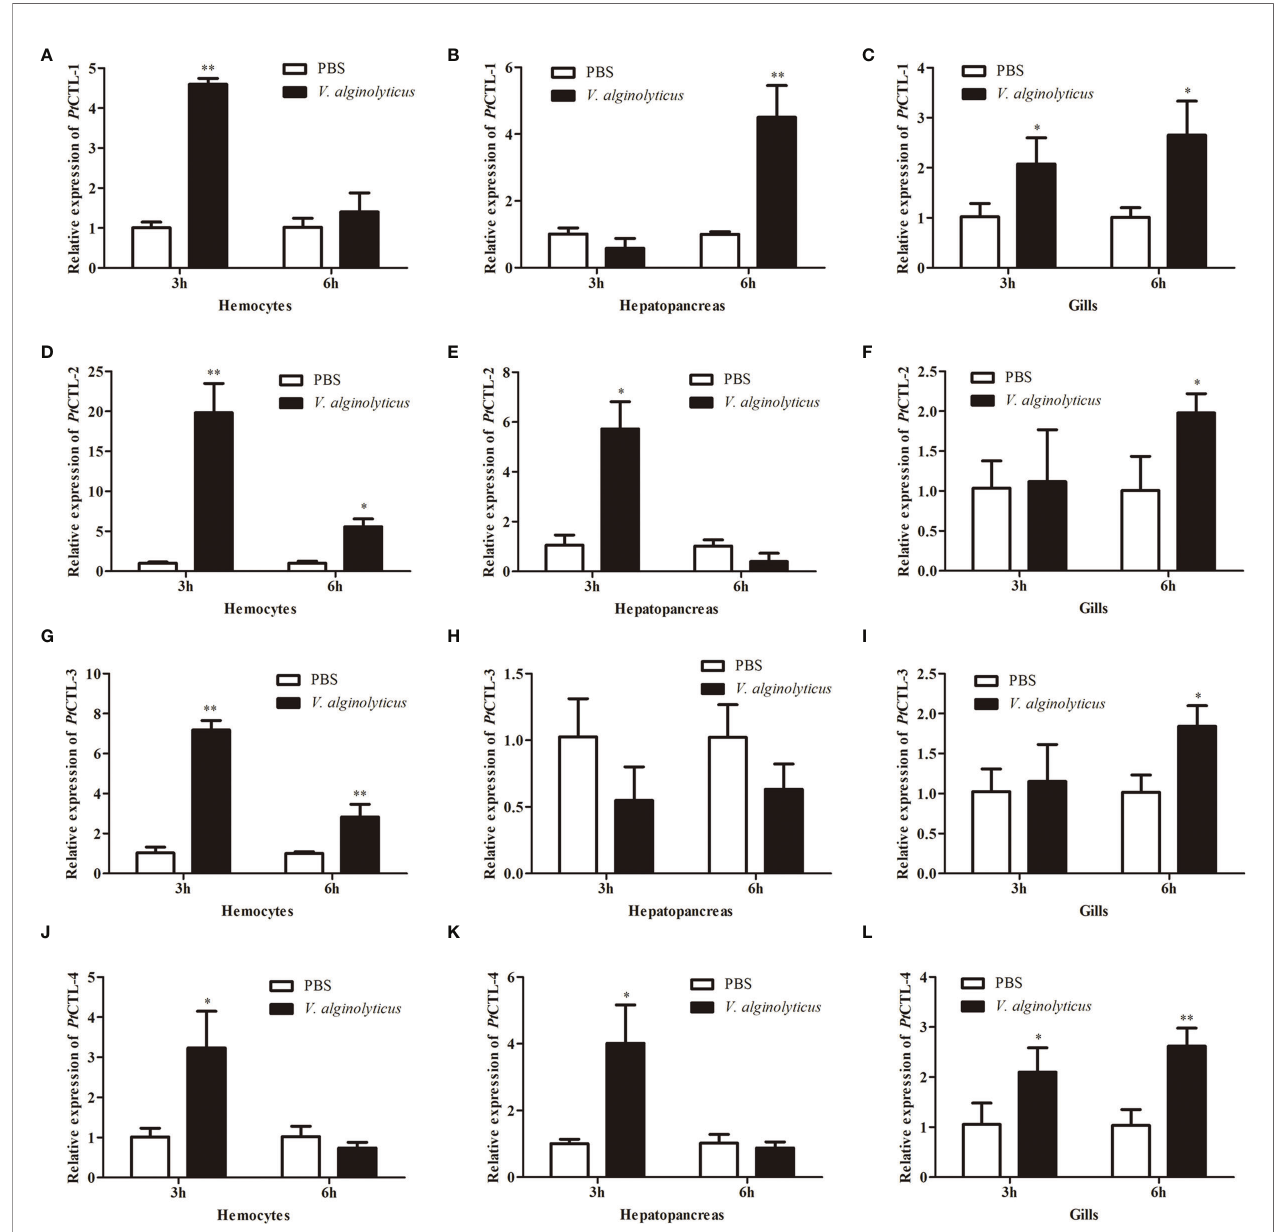
FIGURE 6 | Expression pro fi les of PtCTLs in V. alginolyticu s-challenged P. trituberculatus . The relative expression of PtCTL-1 in hemocytes (A) , hepatopancreas (B) and gills (C) after V. alginolyticus injection; The relative expression of PtCTL-2 in hemocytes (D) , hepatopancreas (E) and gills (F) after V. alginolyticus injection; The relative expression of PtCTL-3 in hemocytes (G) , hepatopancreas (H) and gills (I) after V. alginolyticus injection; The relative expression of PtCTL-4 in hemocytes (J) , hepatopancreas (K) and gills (L) after V. alginolyticus injection. Each bar represents the mean ± SD (n = 5). Asterisks indicate statistically signi fi cant differences: * p < 0.05, ** p <